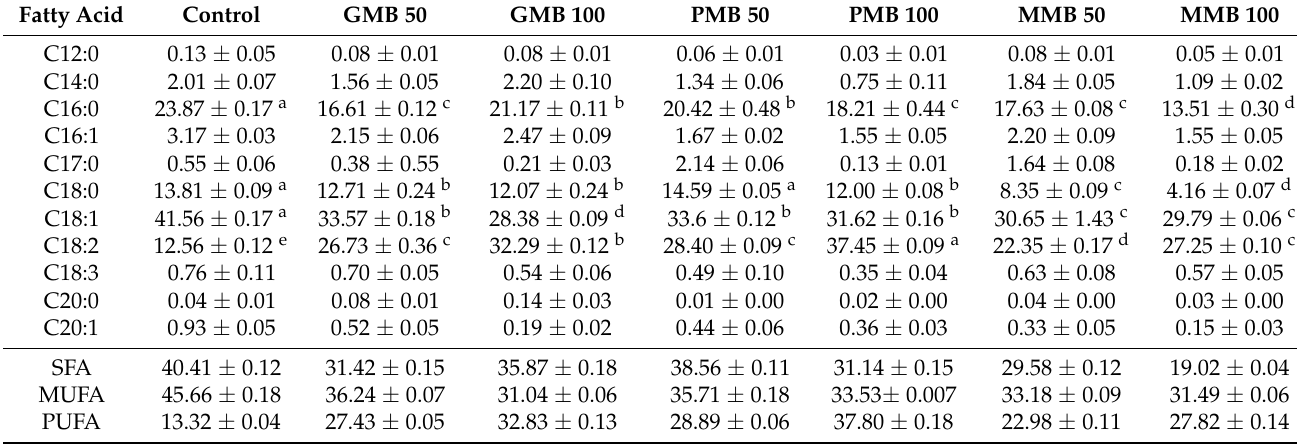
Table 6. Fatty acid composition of the burgers reformulated with melon seed oil.